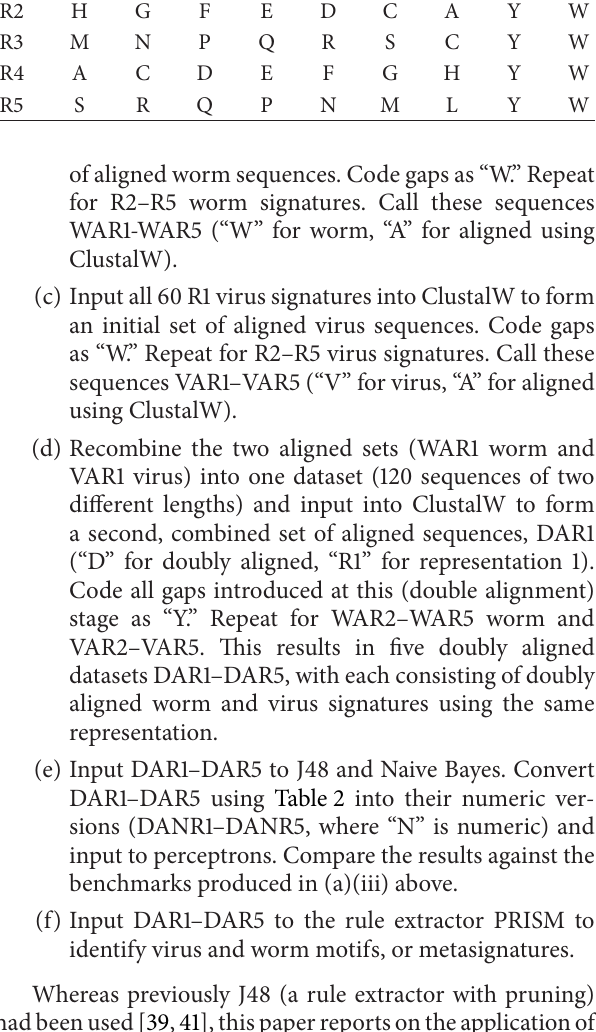
values (Table 2), a hidden layer of 72 units was